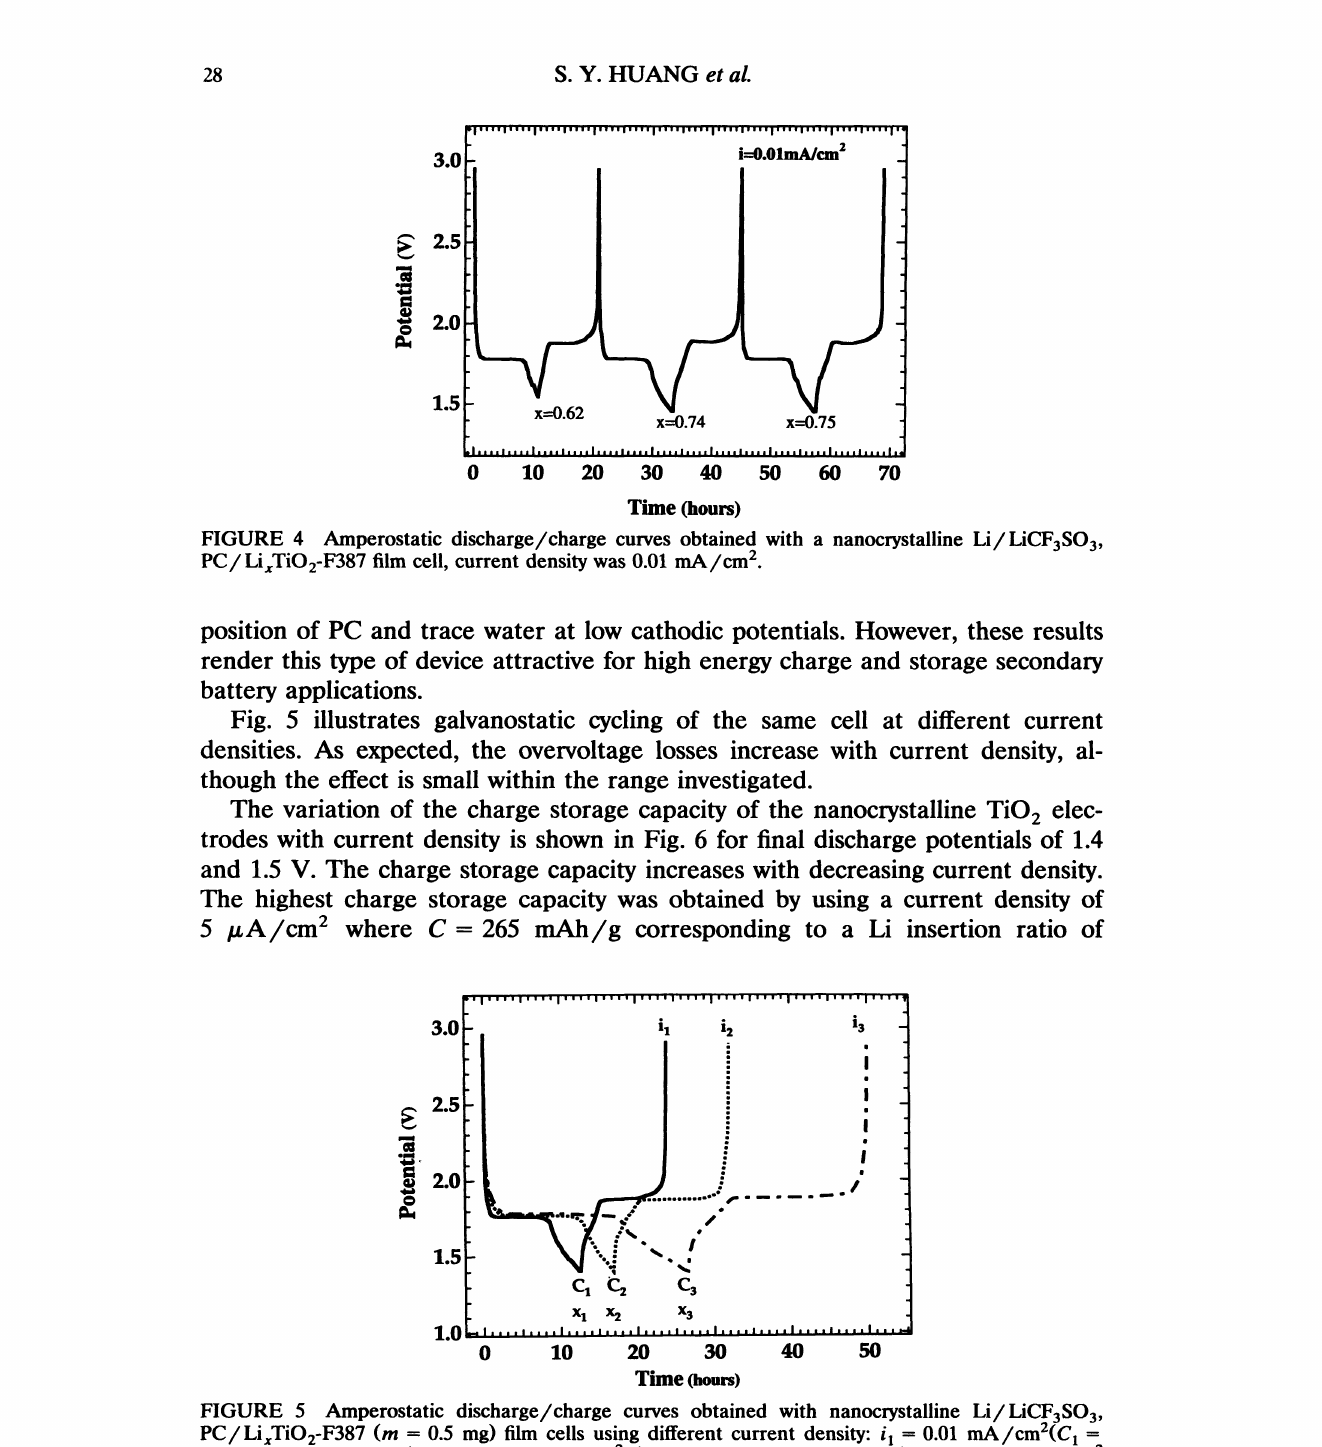
FIGURE 5 Amperostatic discharge/charge curves obtained with nanocrystalline Li/LiC_F3SO3, PC/LixTiO2-F387 (m 0.5 mg) film cells using different current density: